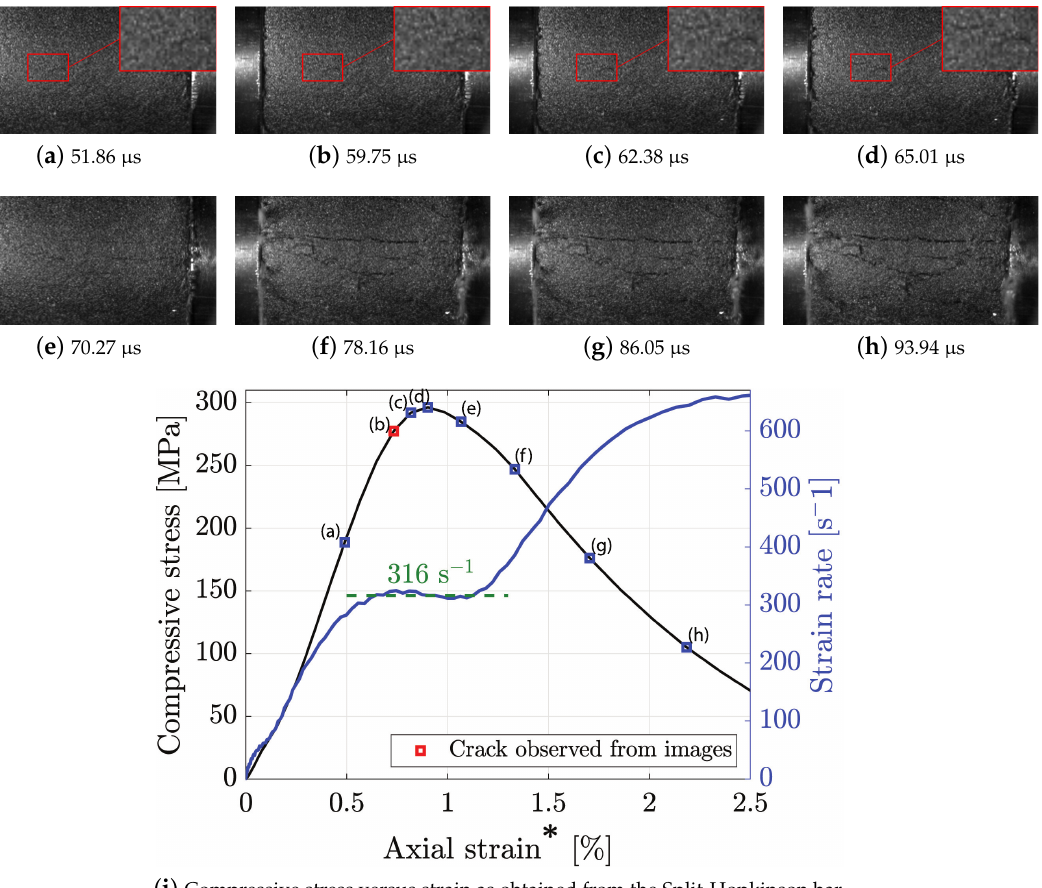
Figure 11. Examples of high-speed images of a dynamic compression test of diorite ( a – h ) and the corresponding stress–strain curve ( i ). The resolution of the high-speed images ( a – h ) is 256 × 128 pixels or 31.5 × 15.8